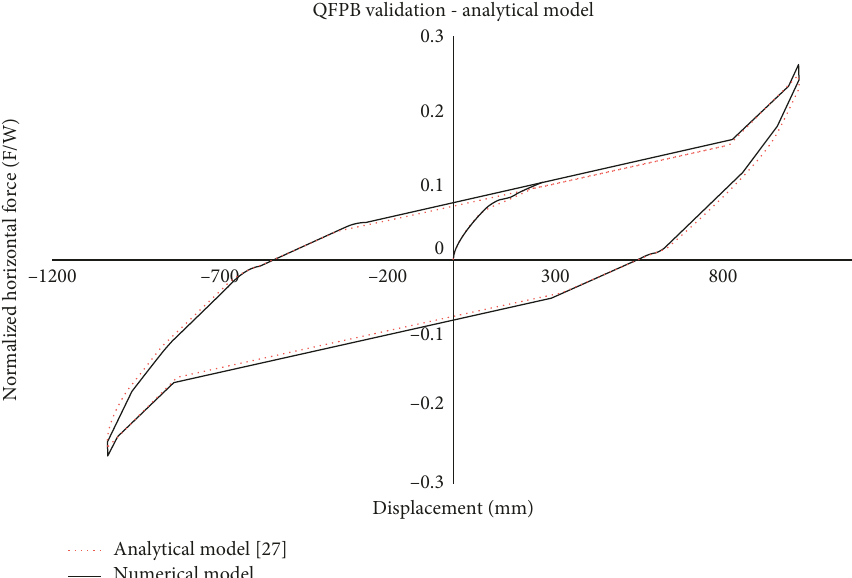
Figure 5: Comparison of current numerical QFPB model with analytical results derived from Lee and Constantinou Table 1: Parameters of the QFPB model (taken from [21]). Displacement Radius (m) Height (m) Coefficient of friction capacity (m)